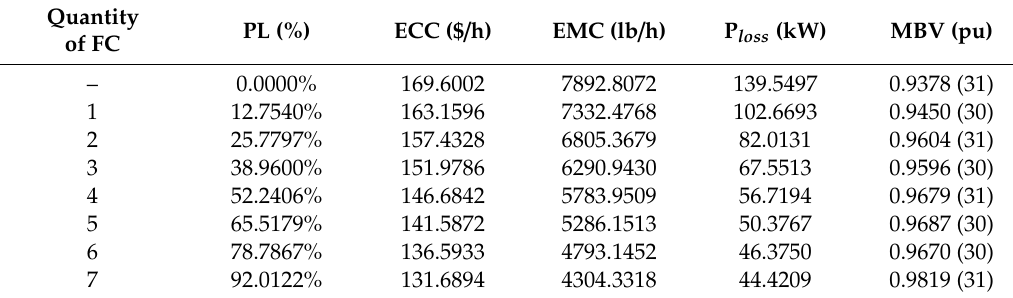
Table 8. Reconfiguration results of the increasing MT